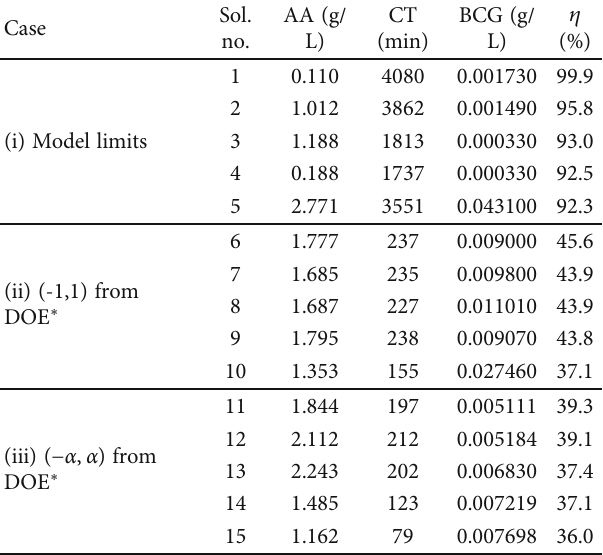
Table 6: Optimization results based on the ANN model. Case